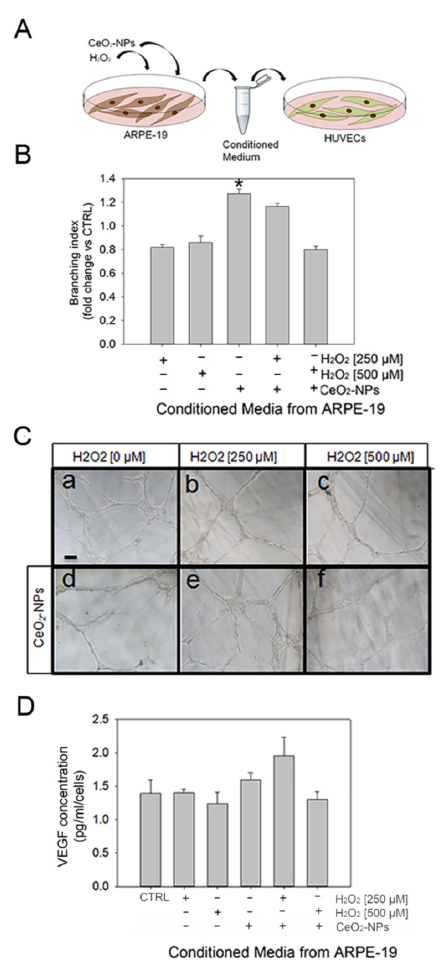
Figure 7. Effects of H 2 O 2 on tubule formation in vitro. ( A ) Schematic representation of the experi- mental workflow. ( B ) Histogram shows the effect of CM from ARPE-19 cells exposed to different treatments (H 2 O 2 at 250 and 500 μ M; CeO 2 -NPs at 0.1 mM, and in combination) on the tubule for- mation of HUVECs. The number of tubules has been measured by counting the number of junc- tions/area (branching index). ( C ) Representative images of tubule formation of HUVECs exposed to CM from ARPE-19 treated with H 2 O 2 (250 μ M and 500 μ M) in the presence or absence of CeO 2 -NPs (0.1 mM) ( a – f ); scale bar: 200 mm. ( D ) VEGF determination in CM from ARPE-19 cells treated with